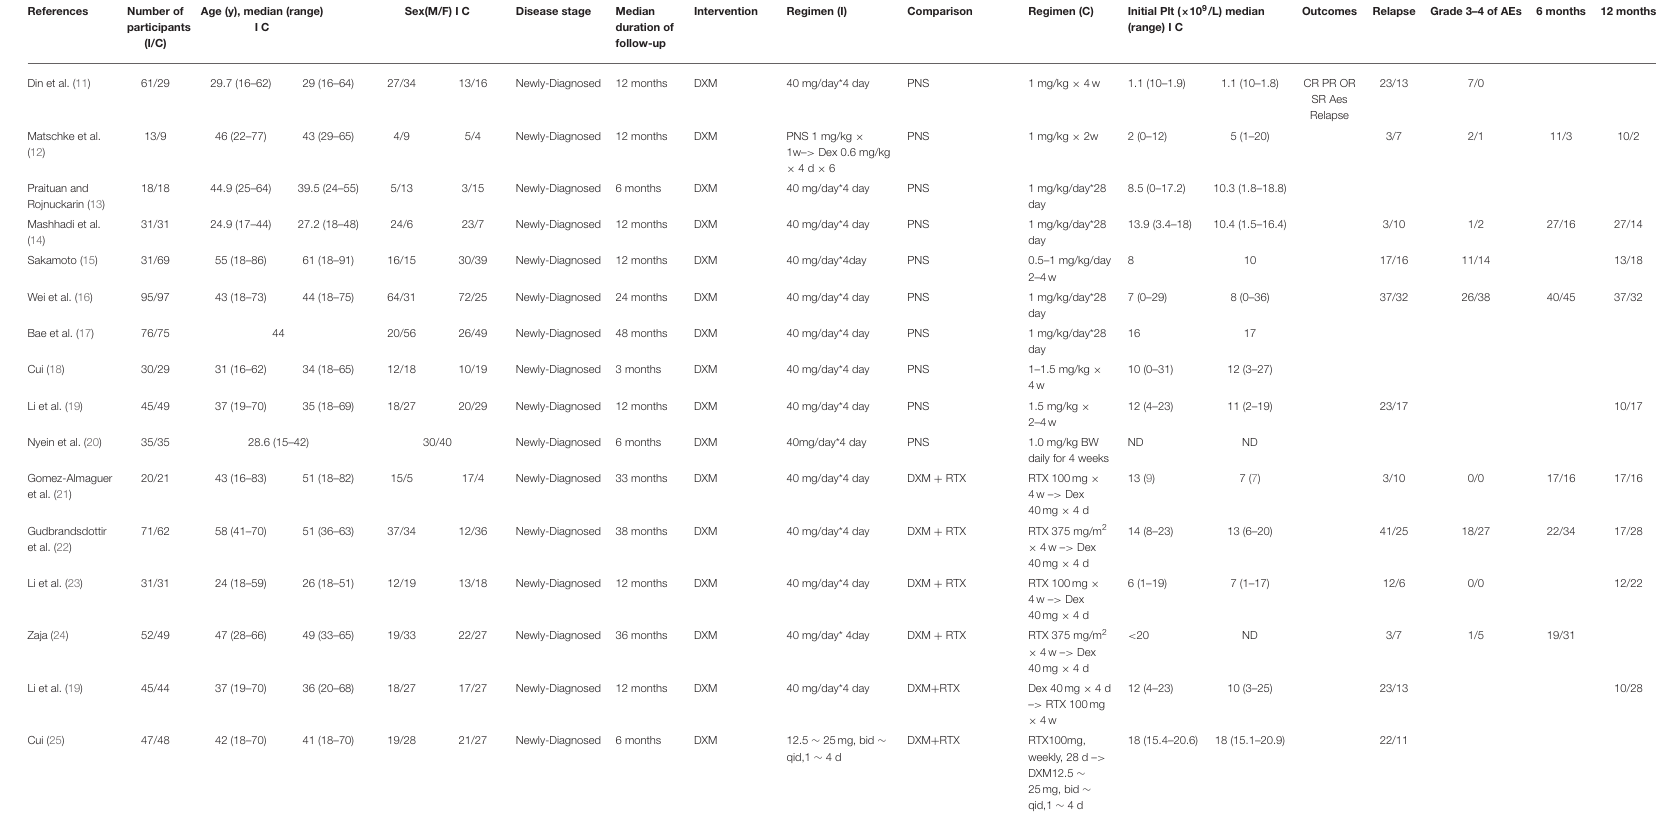
TABLE 1 | Summary of included